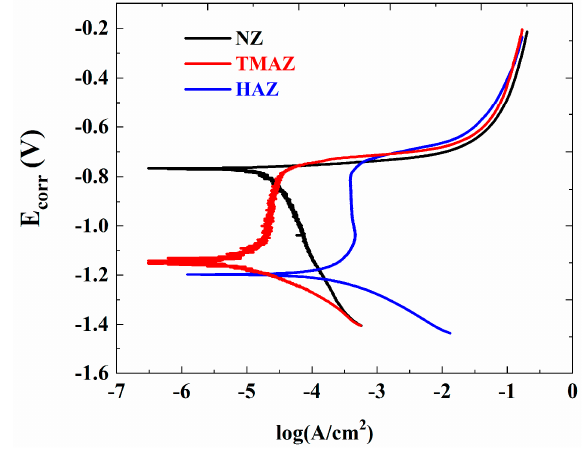
Figure 12. Polarization curves of the joints in 3.5 wt.% NaCl solution in different regions.